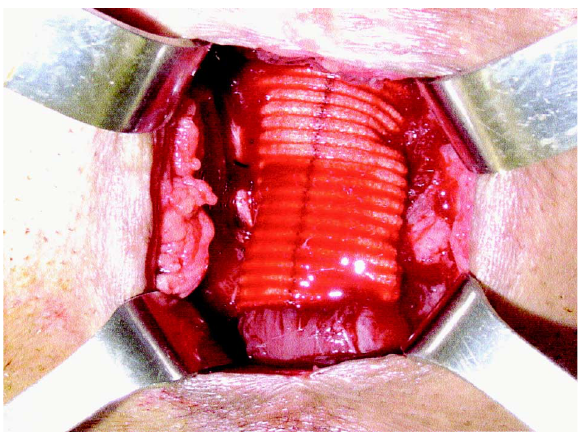
Figure 2 – Sling already fixed on the bulbar urethra.